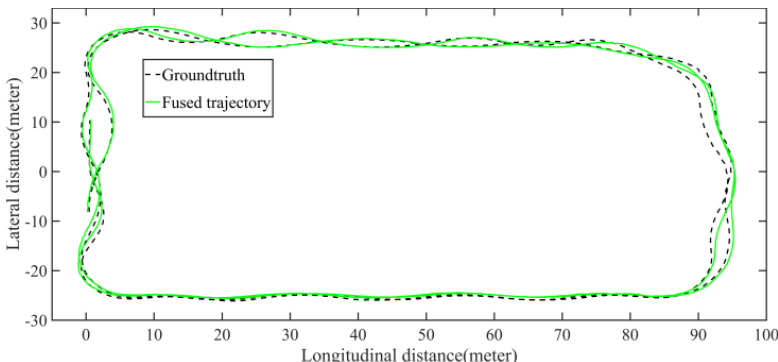
Figure 29. Field test NO.4. Two laps under curve driving scenario localization test in prior point cloud map. The white points in the figure are the point cloud map built by the offline mapping process, the red line is the trajectory of LiDAR matching results, the orange line is groundtruth, and the blue line is the fused trajectory.